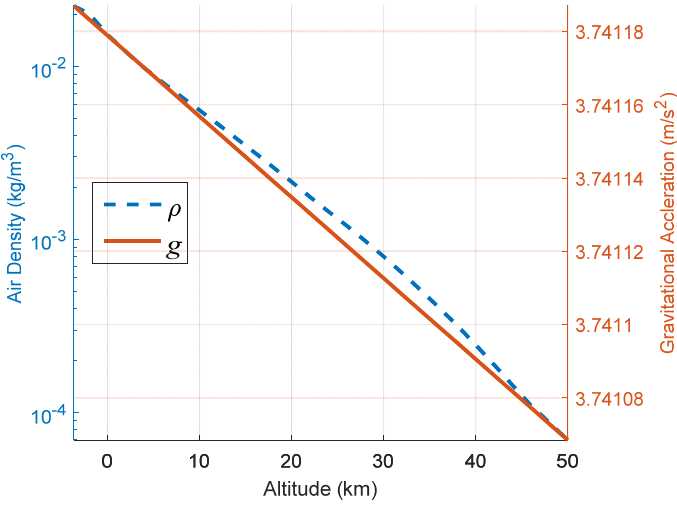
Figure 13. Variations in the air density and gravitational acceleration with the altitude on Mars.